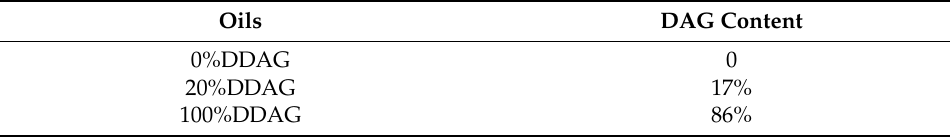
Table 1. The information of three hybrid duck oils used in this